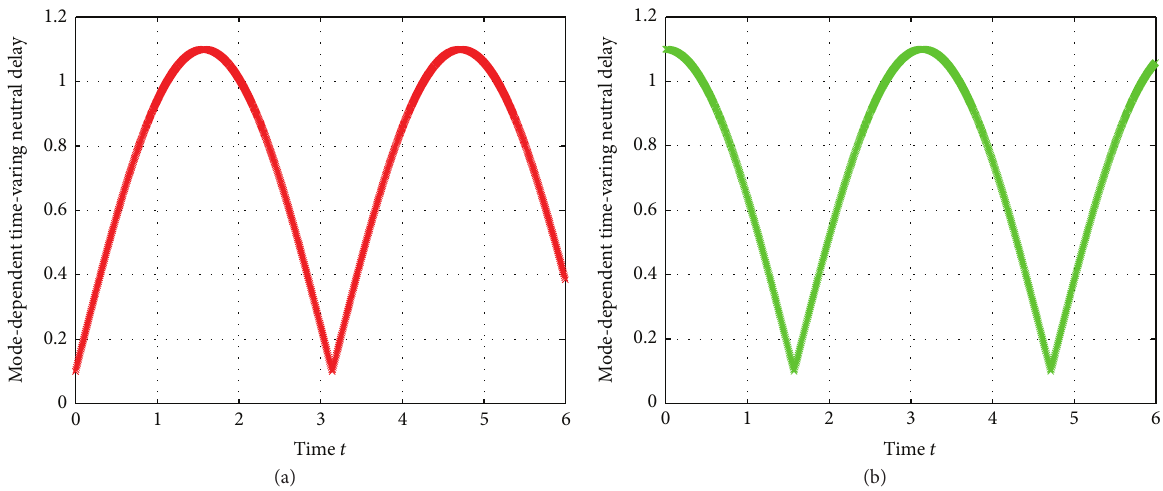
Figure 2: Mode-dependent time-varying retarded delays 𝑑 𝑖 (𝑡) at mode 1 and mode